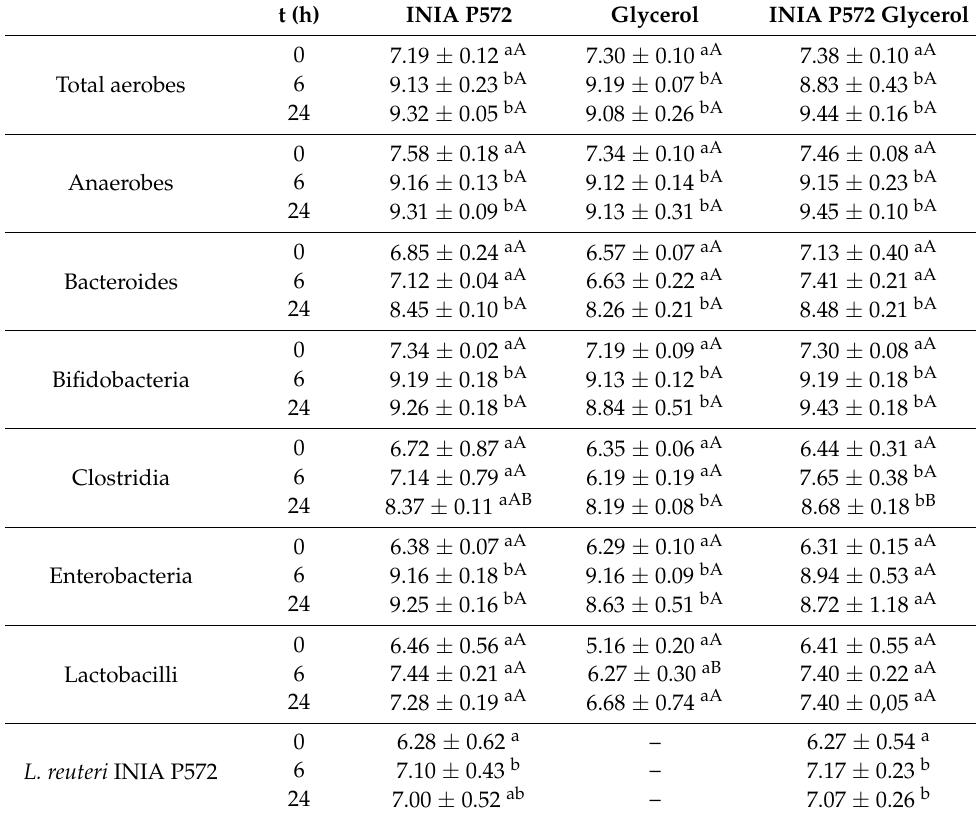
Table 2. Bacterial numbers (log cfu/mL) in samples from batch fermenters inoculated with L. reuteri INIA P572 (INIA P572), 100 mM glycerol (glycerol), and L. reuteri INIA P572 with glycerol (INIA P572